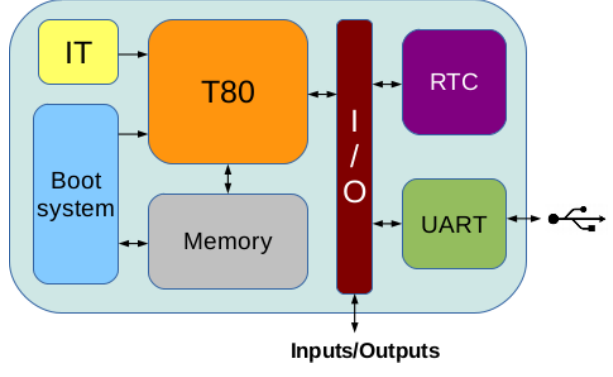
Figure 1. Dracon block diagram.